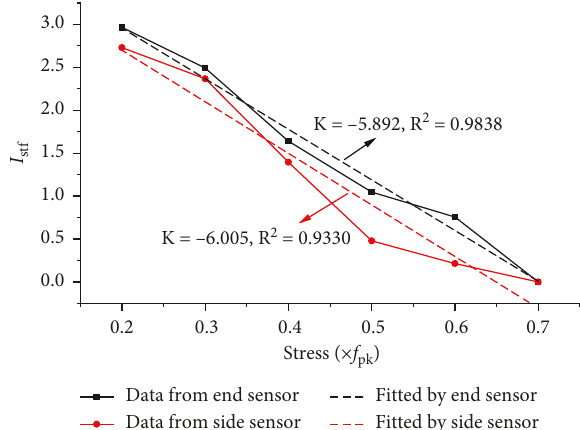
Figure 12: Recognition index curve at different sensors position.